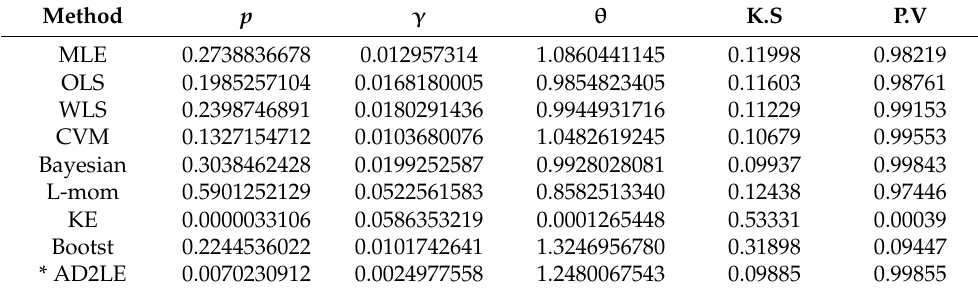
Figure 4. Kaplan–Meier plots under dataset II. Table 9. Comparing methods using dataset